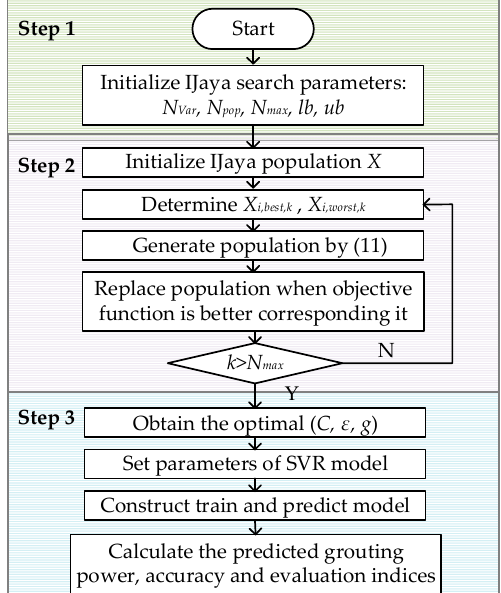
Figure 3. The flow chart of SVR optimized by IJaya.